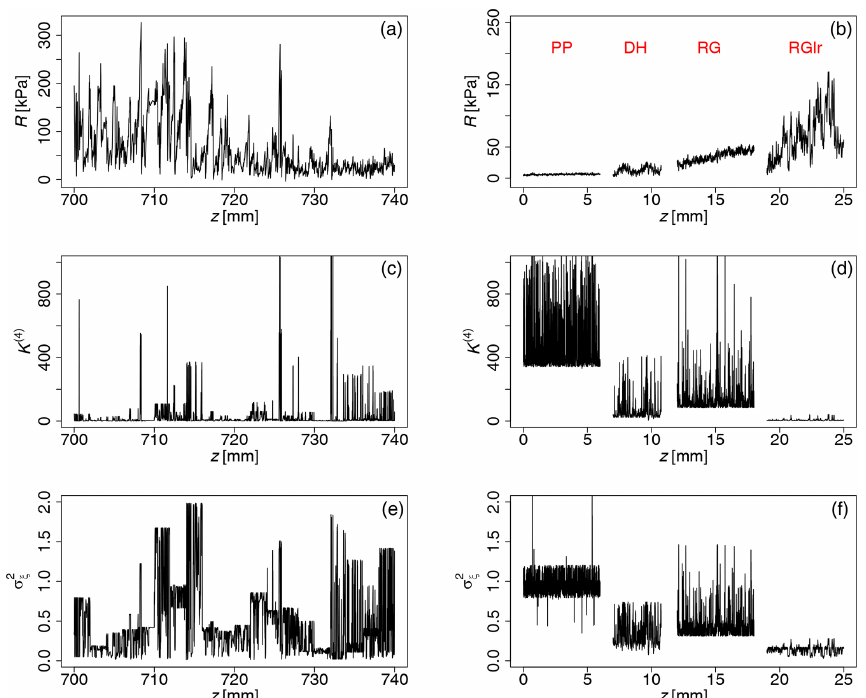
Figure 10. The snow hardness profile of a field measurement together with its fourth-order KM coefficients K ( 4 ) and the jump amplitude σ 2 (z) is shown in (a) , (c) and (e) . These parameters were determined using non-overlapping moving window with 500 data points (2mm) ξ by means of the Nadaraya–Watson estimator. Snow hardness profiles of the laboratory-prepared snow types and their local parameters are also plotted to enable better comparison (b, d, f) ; they are shifted horizontally for better visualization. The results of field measurements are shown at the depth of 700mm < z < 740mm. With reference to the local characteristic snow types from laboratory measurements, we can see in the dynamics that mixtures of different snow types are present in this section of measurement. For 732mm < z < 740mm, the high K ( 4 ) and σ 2 indicate the presence of small and less dense structures of snow which resemble the RG-like snow ξ